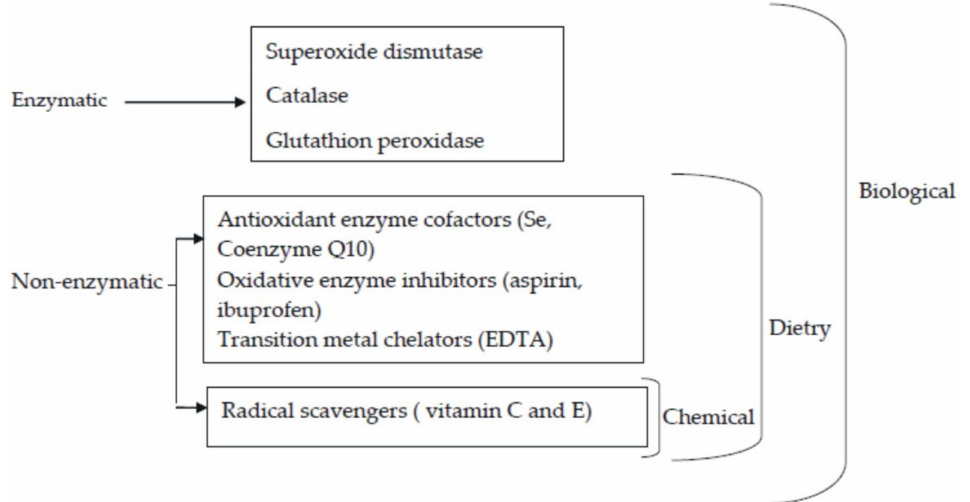
Figure 2. Application scope of antioxidants